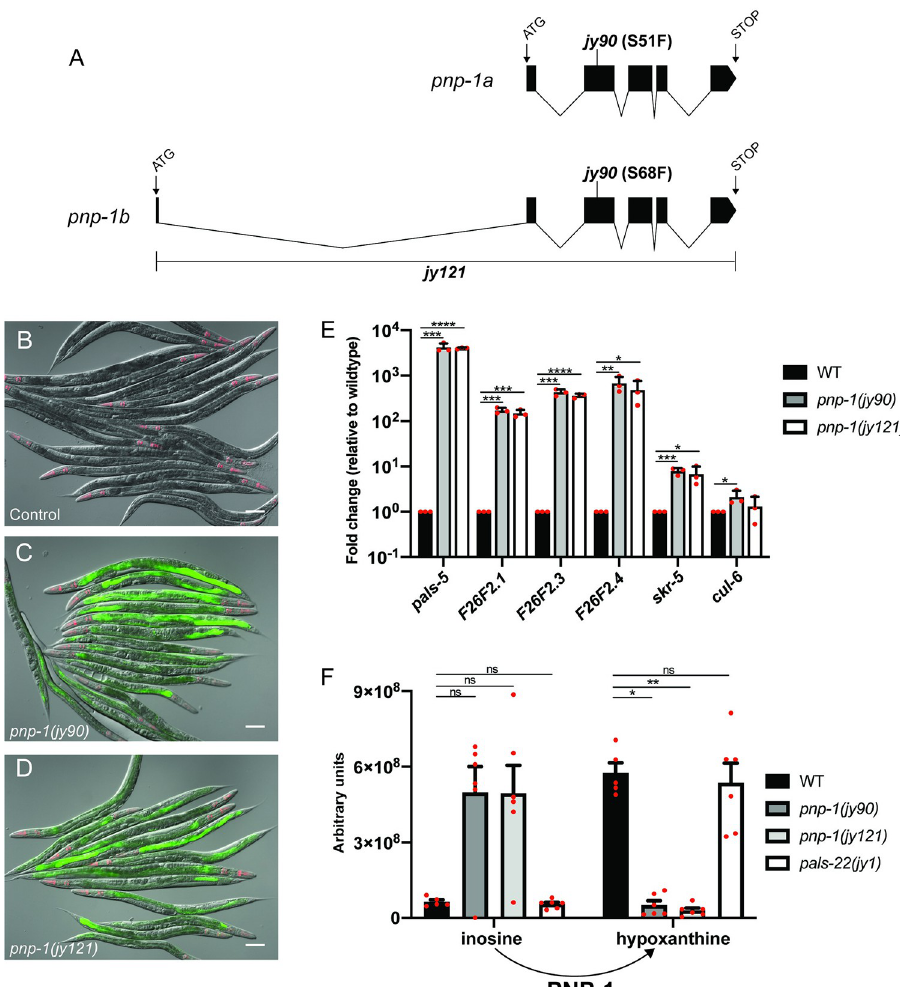
Fig 1. pnp-1 mutants have increased expression of IPR genes. A) Gene structure of the two isoforms of pnp-1 with exons indicated as black boxes. 5’ and 3’ untranslated regions are not shown. B-D) pals-5p :: gfp IPR reporter expression in wild-type animals, pnp-1(jy90) and pnp-1(jy121) mutants. myo-2p :: mCherry is a pharyngeal marker for the presence of the IPR reporter transgene. Scale bar is 100 μ m. E) qRT-PCR of a subset of IPR genes in pnp-1(jy90) and pnp-1 (jy121) mutants. Fold change in gene expression is shown relative to wild-type animals. Graph shows the mean fold change of three independent experiments. Error bars are standard deviation (SD). Mixed stage populations of animals were used. ���� indicates p < 0.0001 by one-tailed t-test. F) Quantification of inosine and hypoxanthine levels in pnp-1 and pals-22 mutants from metabolomics analysis. Graph shows the mean levels of metabolites from six independent experiments for pnp-1(jy121) , pnp-1(jy90) and pals-22(jy1) mutants, and five independent experiments for wild-type animals. Error bars are standard error of the mean (SEM). �� indicates p < 0.01 by the Kruskal-Wallis test. E, F) Red dots indicate values from individual experiments. See materials and methods for more